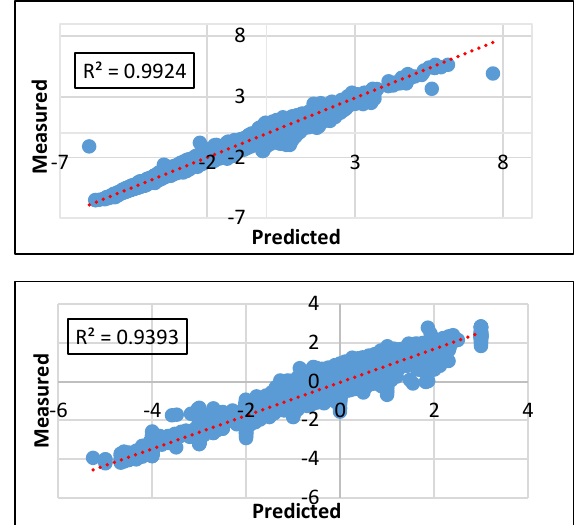
Figure 4. 2D scatter-plot between measured and estimated depth values using OK Method, 2012 data (top) and 2006 data